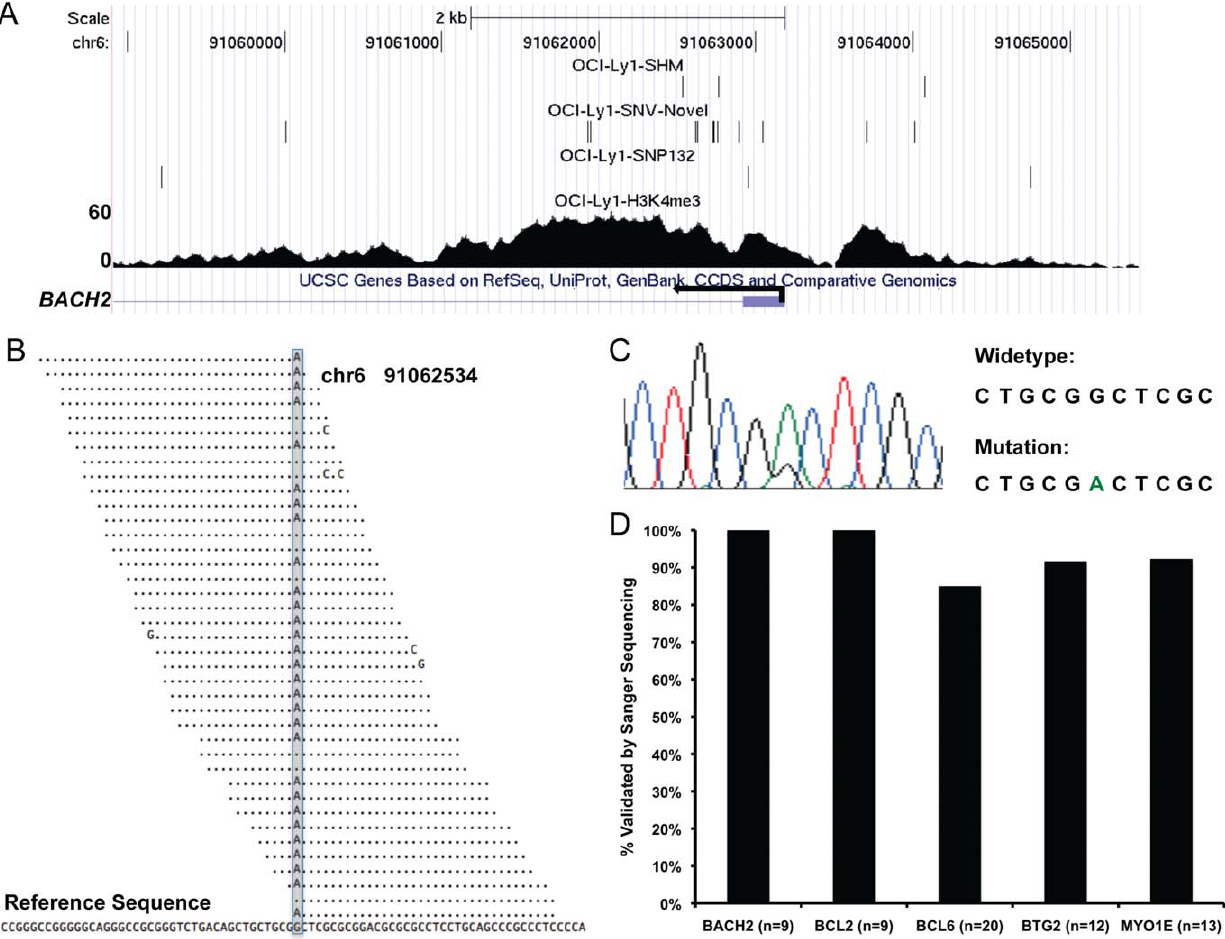
Figure 3. Detection of SHM. (A). A snapshot of UCSC genome browser showing H3K4me3 ChIP-seq reads density at BACH2 promoter. The top three tracks represent SHMs, novel SNVs, and known SNVs (SNP132) detected in OCI-Ly1 by applying SHMseeqer to OCI-Ly1 H3K4me3 ChIP-seq short reads. (B). OCI-Ly1 H3K4me3 ChIP-seq short reads spanning chr6 position 91062534 ( BACH2 intron 1) where a SHM was detected (shaded). (C). Sanger sequencing trace showing detection of both G (wild-type) and A (mutation) at chr6 position 91062534 in OCI-Ly1. (D). Overall validation rates of selected SNVs/SHMs within BACH2 , BCL2 , BCL6 , BTG2 , and MYO1E loci. N indicates number of SNVs/SHMs validated by Sanger sequencing in each